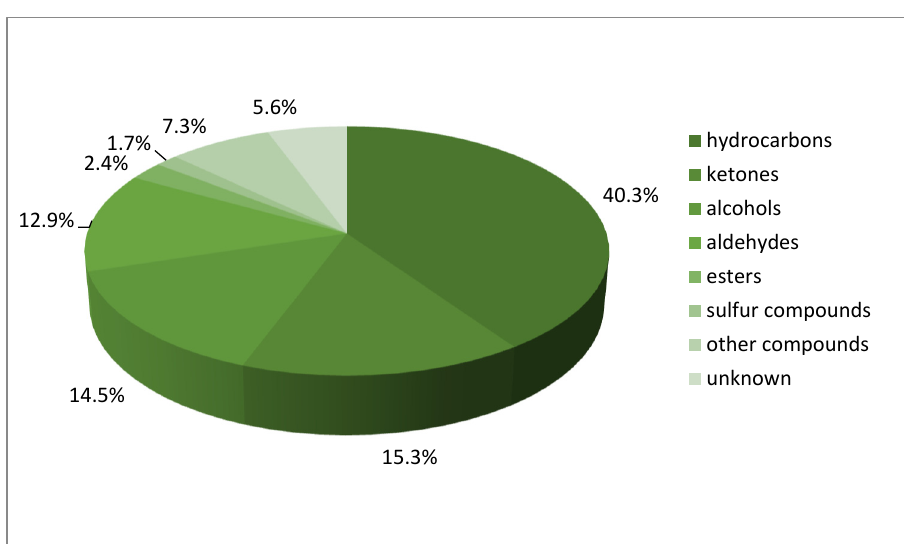
Figure 3. Grouping of the organic volatile compounds found in the examined honey samples.